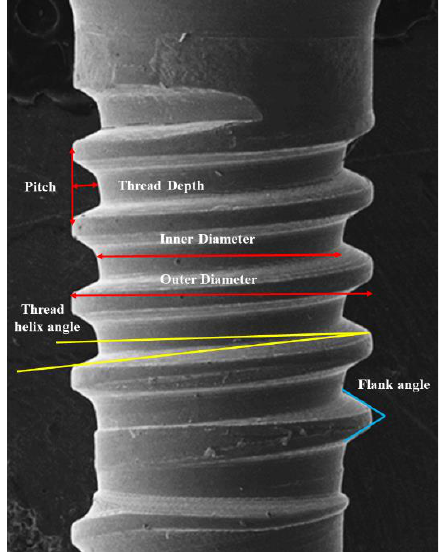
Figure 2. Surface features of thread (Type C; microthread neck) using scanning electron microscopy (15 kV × 30, Hitachi SU8010, Japan). Red double-headed arrows: dimensions of thread. Yellow: flank angle. Blue: thread helix angle.